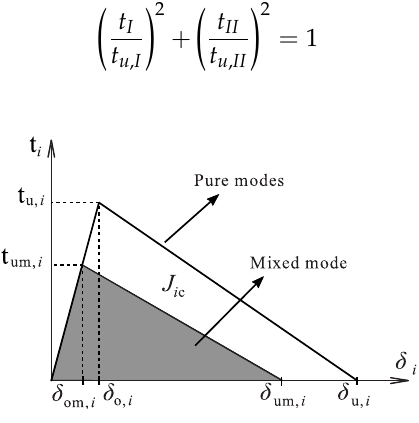
Table 3. Mechanical properties of adhesive [18].